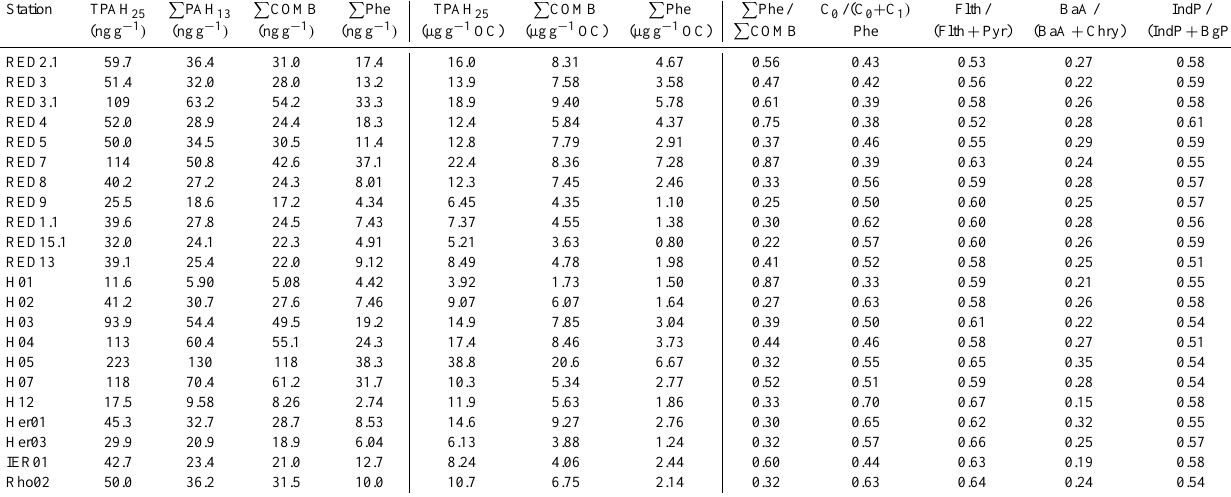
Table 3. Concentrations (per dry weight and OC-normalized), characteristic parameters and source-specific diagnostic ratios of polycyclic aromatic hydrocarbons (PAHs) determined in deep-sea sediments of the eastern Mediterranean Sea.